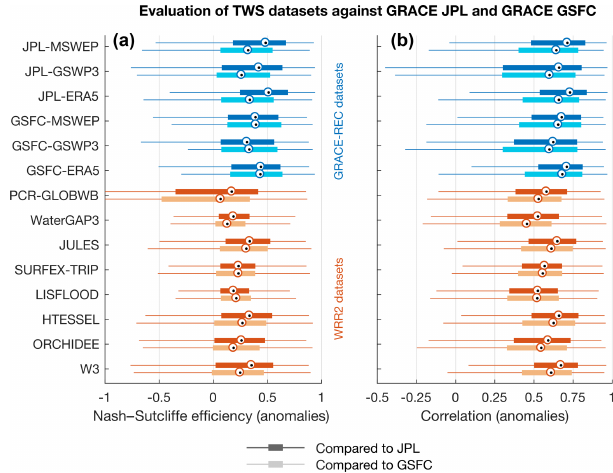
Figure 7. Global-area-weighted box plots of the performance met- rics shown in Figs. 5 and 6 for GRACE-REC datasets (blue), and comparison with the performance of global hydrological models participating in the Earth2Observe Water Resources Reanalysis ver- sion 2 (WRR2) (orange). Dark colors indicate the performance ob- tained when comparing against 3 ◦ × 3 ◦ JPL mascons, and against 1 ◦ × 1 ◦ GSFC mascons for light colors. Note that WRR2 models are driven with MSWEP precipitation and all model outputs are aggregated to the resolution of the corresponding GRACE dataset. Greenland and Antarctica are always excluded.